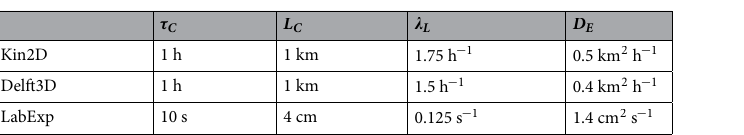
Table 2. Lagrangian characteristic quantities measured from the trajectory data analysis of the three systems: Kin2D, Delft3D and LabExp. See caption of Table 1 for explanation of the